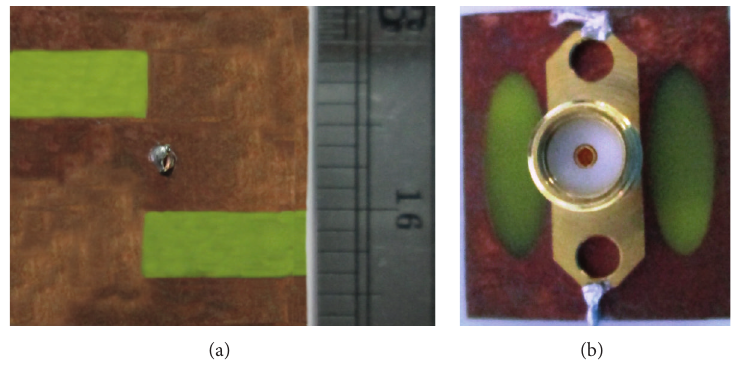
Figure 13: Proposed antenna prototype: (a) top view and (b) bottom view.